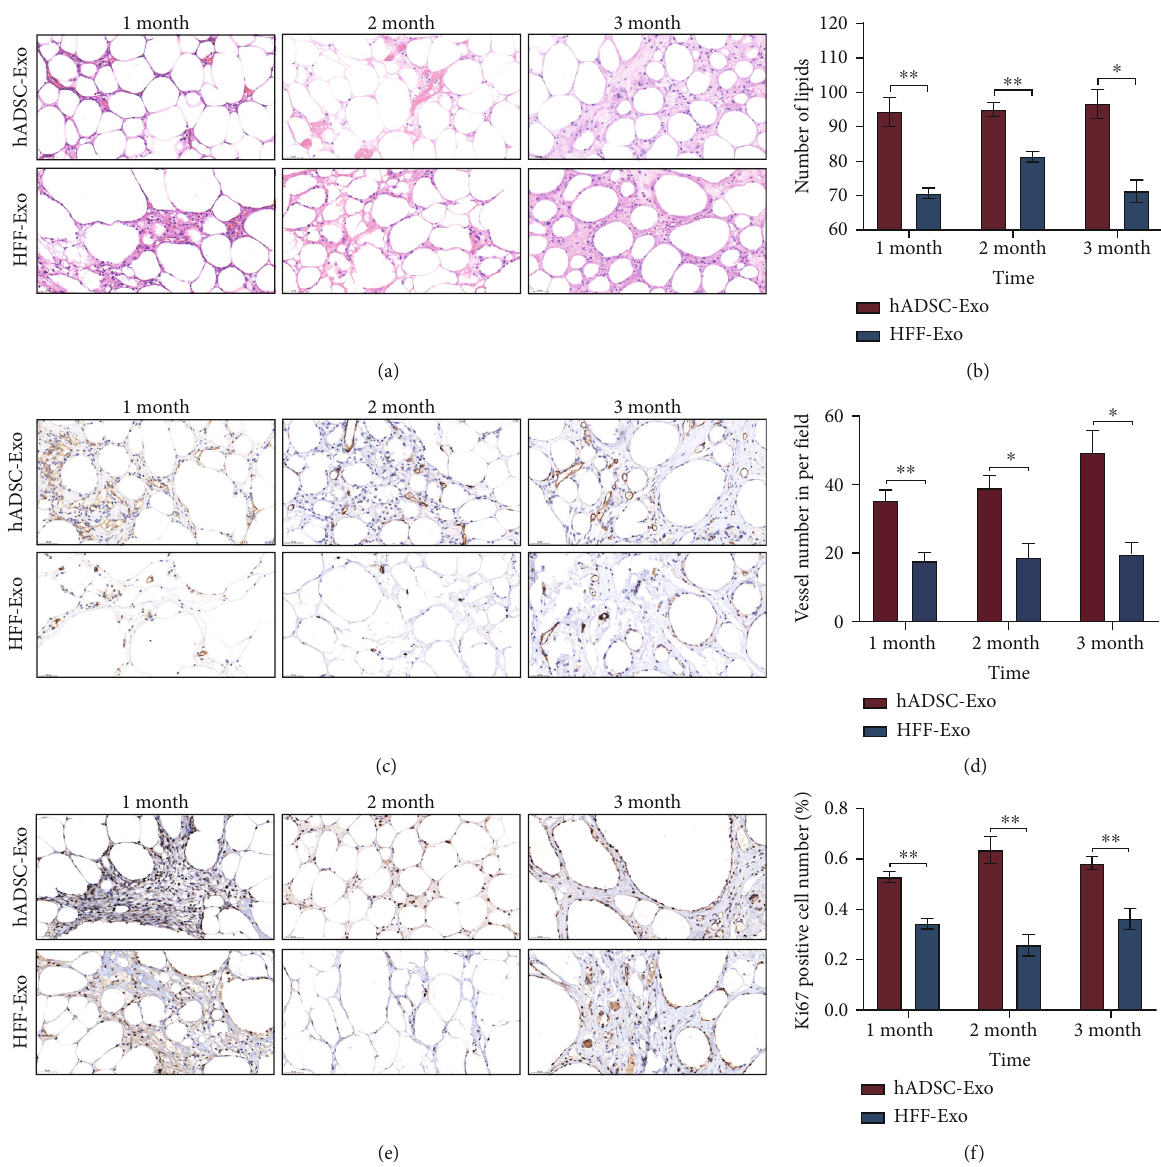
Figure 3: hADSC-Exo promoted the retention and neovascularization of adipose grafts in the nude mice fat grafting model. (a) HE staining revealed that the transplanted fat in the hADSC-Exo groups showed higher adipose number and more complete adipose morphological structure compared to the HFF-Exo group. (b) Semiquantitative scale of integrity of HE staining. (c – f) The number of CD31-positive blood vessels and Ki67-positive proliferating cells in the hADSC-Exo group were signi fi cantly higher than that in the HFF-Exo group ( ∗ p < 0 : 05 , ∗∗ p < 0 : 01 , and ∗∗∗ p < 0 : 001